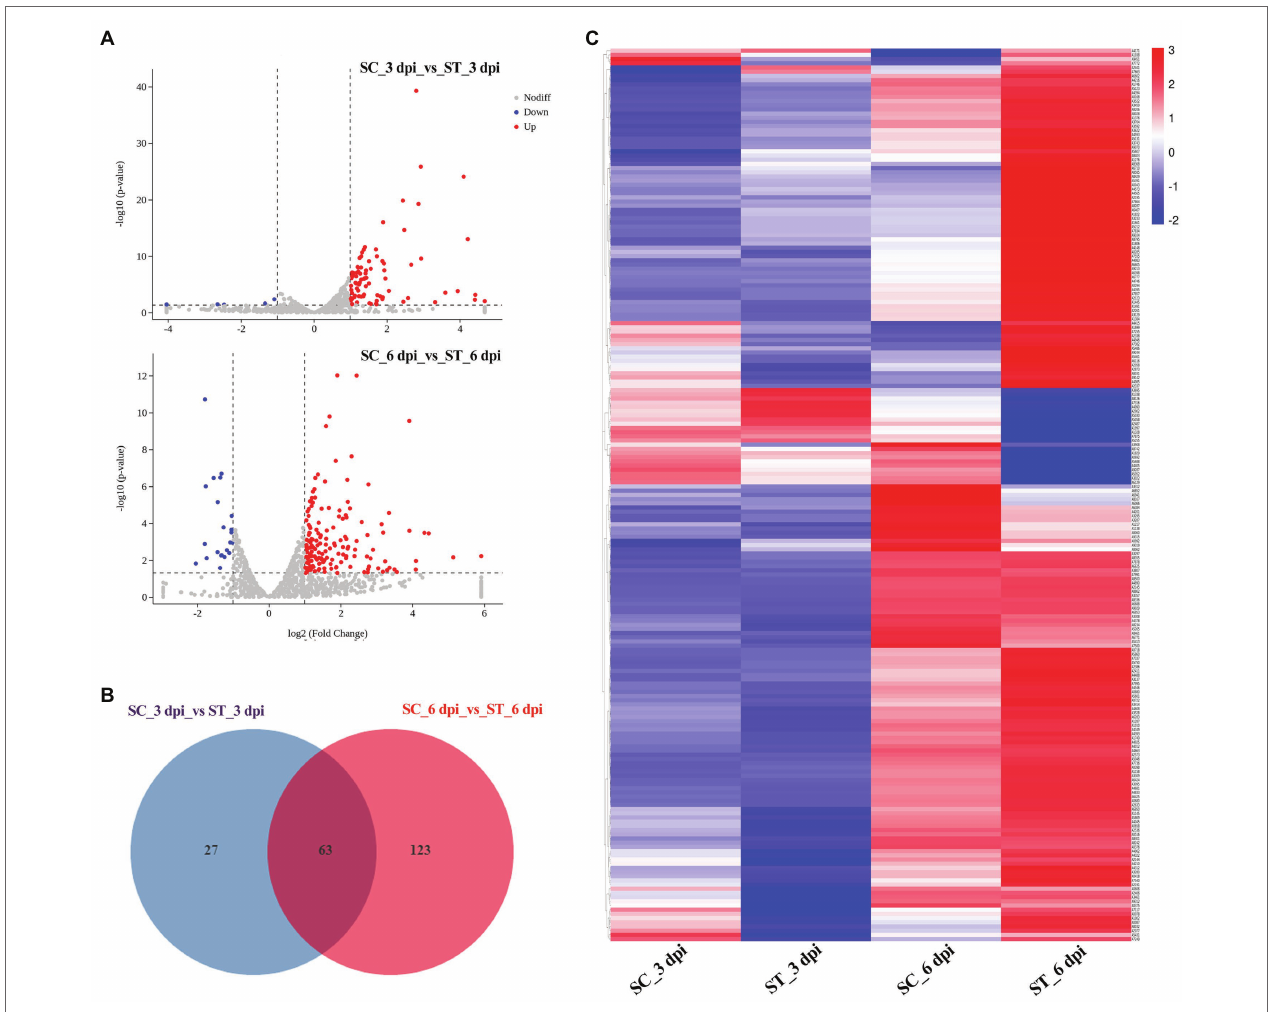
FIGURE 5 | DEGs in M. sextelata at 3 and 6 days post-inoculation. Volcano plot (A) , Venn diagrams (B) and heat maps (C) of the DEGs modulated by P. penicillatus infection in M. sextelata . Blue indicates downregulated DEGs, while red indicates upregulated DEGs in heat maps. ST and SC represent the inoculated and non-inoculated samples, respectively. DEGs, differentially expressed genes; dpi, days